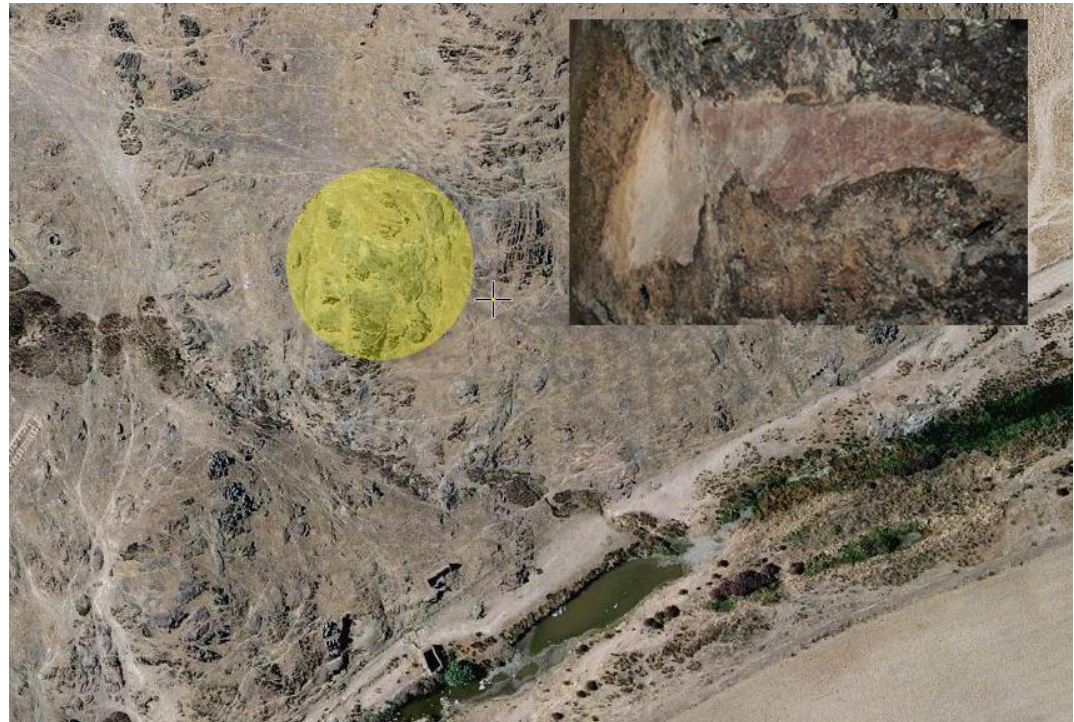
Figure 3. Location and overview of La Roca de los Carros (Campanario).